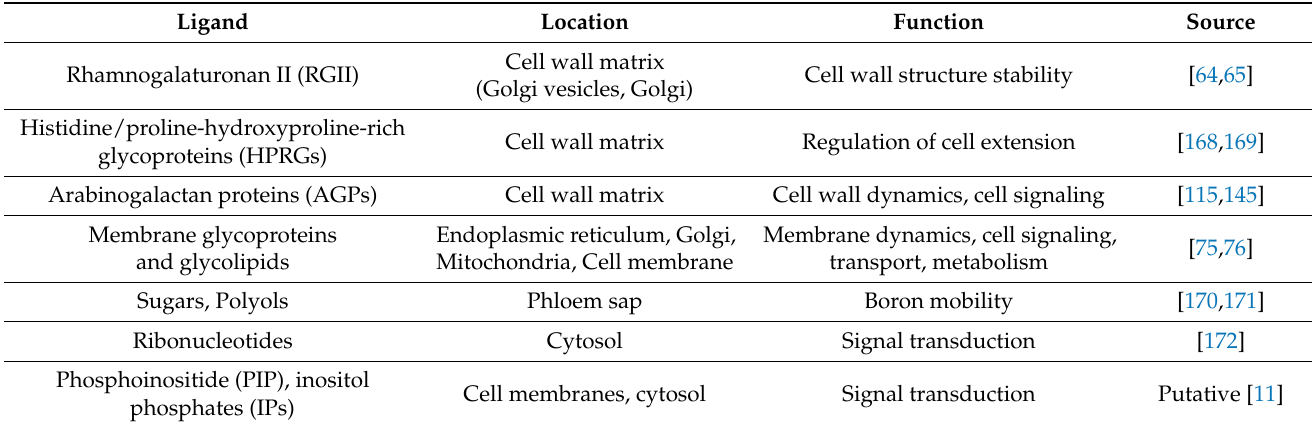
Table 1. Boron binding molecules in